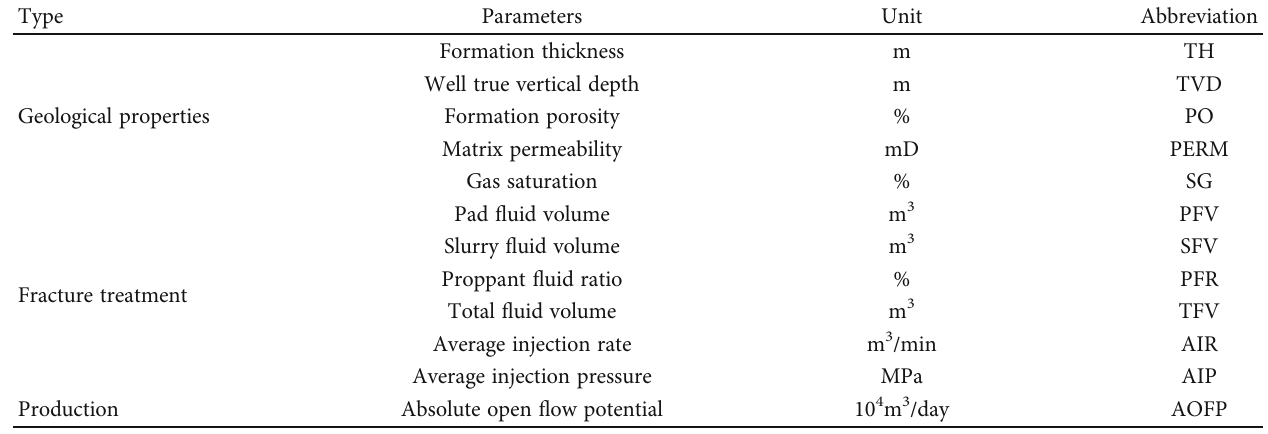
Table 1: Lists of modelling